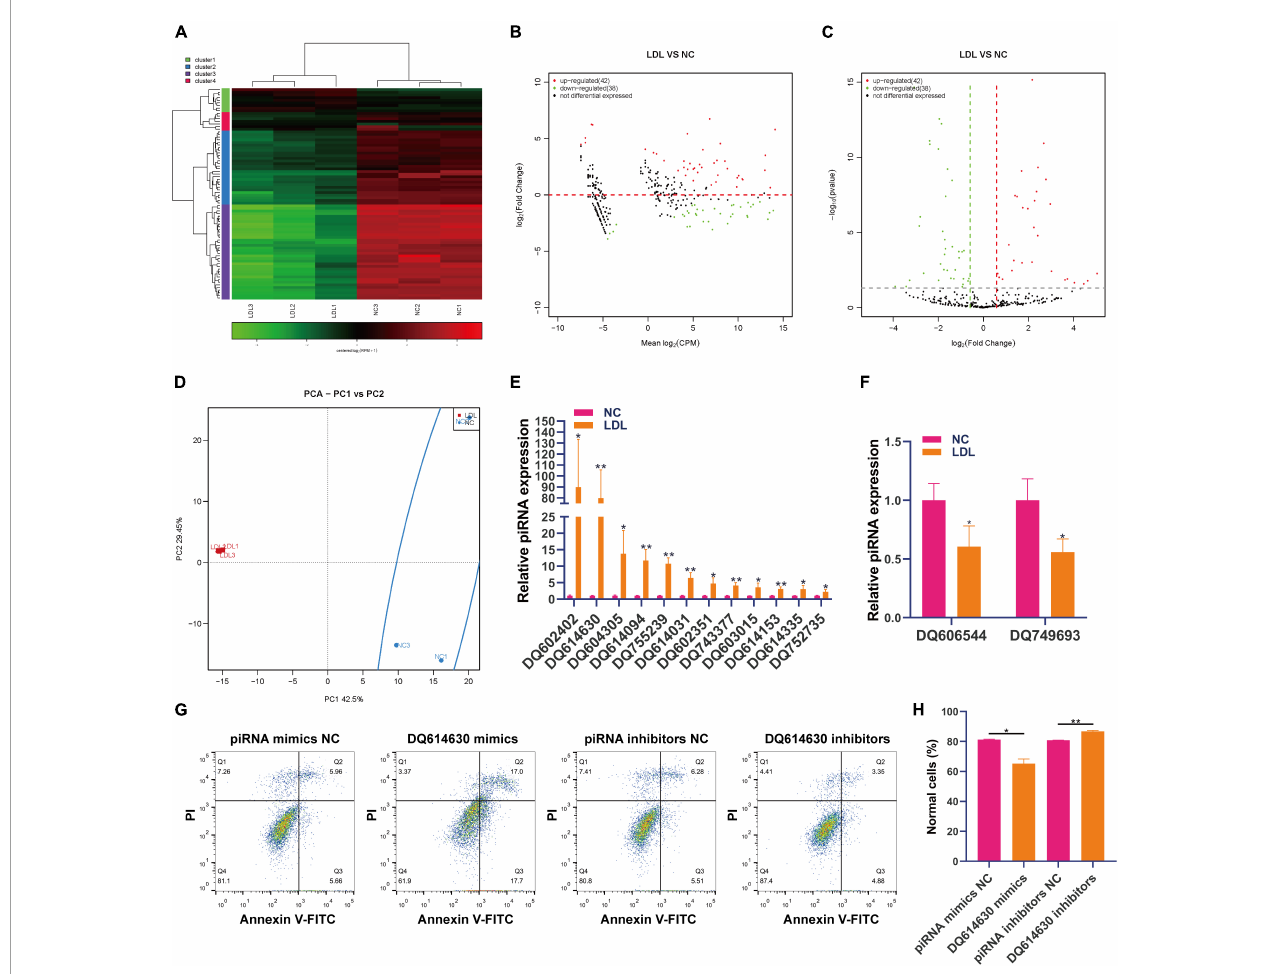
FIGURE1 Differential expression of piRNAs in rat endothelial cells treated with ox-LDL. Heatmap (A) , MA map (B) , and volcano map (C) show the expression of piRNA in rat endothelial cells with ox-LDL treatment, n = 3. (D) PCA showed the expression of piRNA in rat endothelial cells with or without ox-LDL treatment, n = 3. (E) qPCR detected the expression of piRNA in rat endothelial cells with or without ox-LDL treatment. (F) qPCR detected the expression of piRNA in rat endothelial cells with or without ox-LDL treatment. (G) Flow cytometry analysis of cell apoptosis after treatment with piRNA DQ614630 mimics and piRNA DQ614630 inhibitors. (H) Quantification of normal cells according to flow cytometric analysis. For the statistical analysis, three independent experiments were conducted. * p < 0.05, ** p <